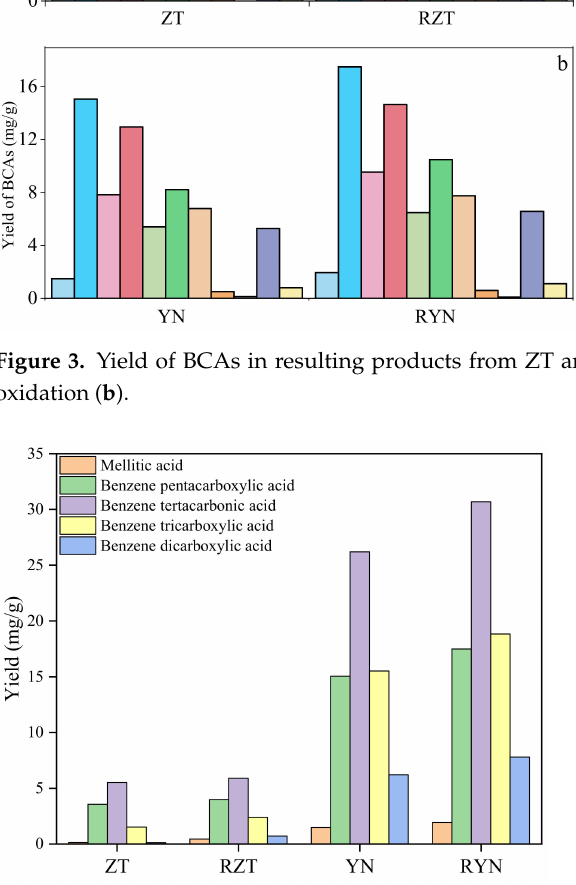
Figure 4. Distribution of BCAs in resulting products from oxidation of coal